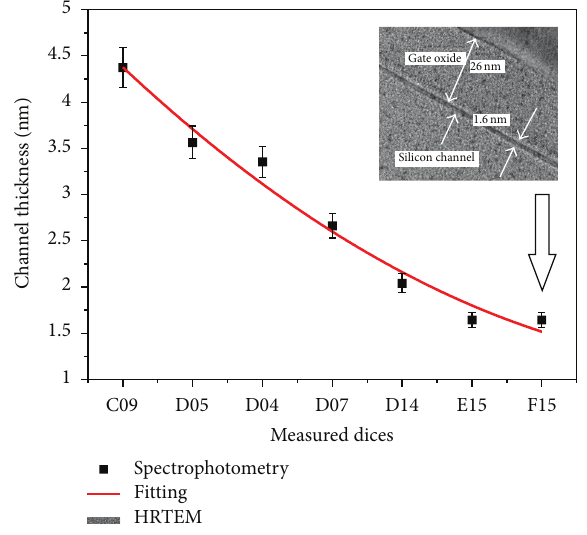
Figure 2: Spectrophotometry measurements of the channel thick- ness performed on the tested dices containing Nano-Scale Body (NSB) devices (from 4.4 to 1.6nm). The dices were cut from the same 2 󸀠󸀠 diameter SIMOX wafer. The accuracy of the measurements is confirmed by inserted HRTEM picture for the smallest channel thickness value (1.6nm). The fitting is serving as a visual guide of the thickness